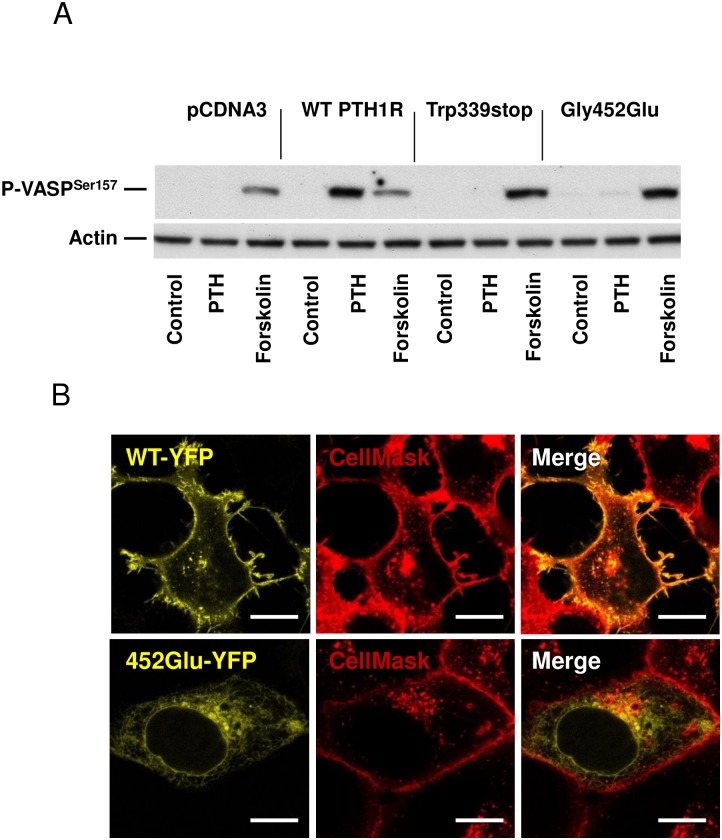
Stimulation and localization of PTH1R wild type or PTH1R mutants.(A) Extracts of stimulated (as indicated) HEK293 cells transfected with pcDNA3, pcDNA3:PTH1R wild type (WT), pcDNA3:PTH1R/Trp339stop or pcDNA3:PTH1R/Gly452Glu mutant were analyzed for VASP phosphorylation at the cAMP/PKA-preferred site Serine 157 (upper panel). Blotting against actin was used as loading control and used for quantification of VASP phosphorylation (lower panel). Representative blots of three independent experiments are shown. (B) Representative images from confocal imaging of YFP-tagged wild type (WT-YFP) and PTH1R/Gly452Glu (452Glu-YFP) in transfected HEK293 cells. CellMask deep red membrane dye was used for membrane staining. Scale bar 10 μM.